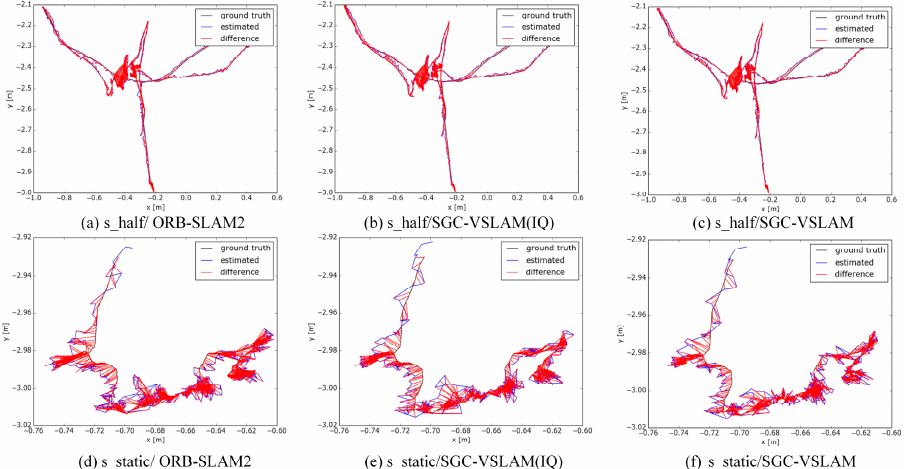
Figure 5. The SLAM trajectory in the high-dynamic sequence. Three systems were tested on the high dynamic sequences. The same row in the figure is the test results of the systems on the same test sequence. The first column in the figure represents the test results of ORB-SLAM2, the second column denotes SGC-VSLAM(IQ) and the third column is the test trajectory of SGC-VSLAM.